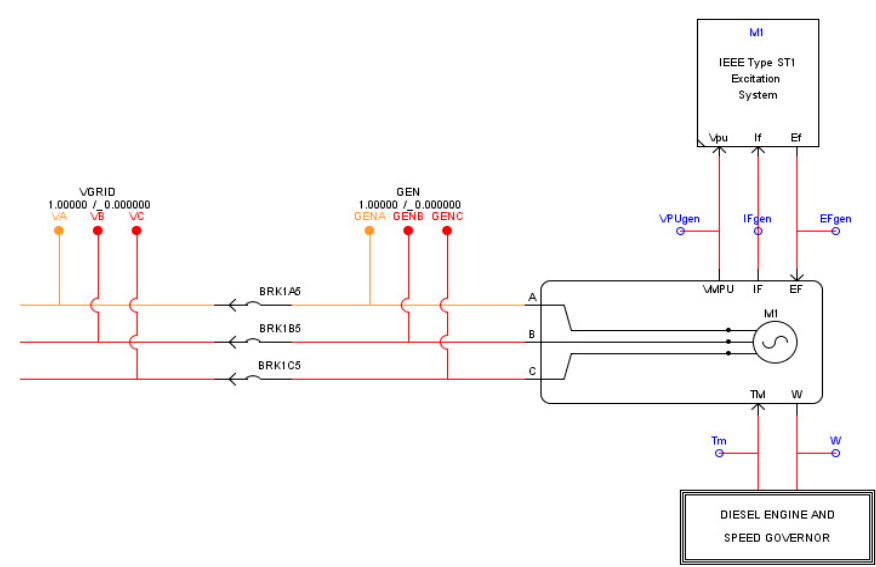
Figure 6. Diesel generator, exciter and speed governor.